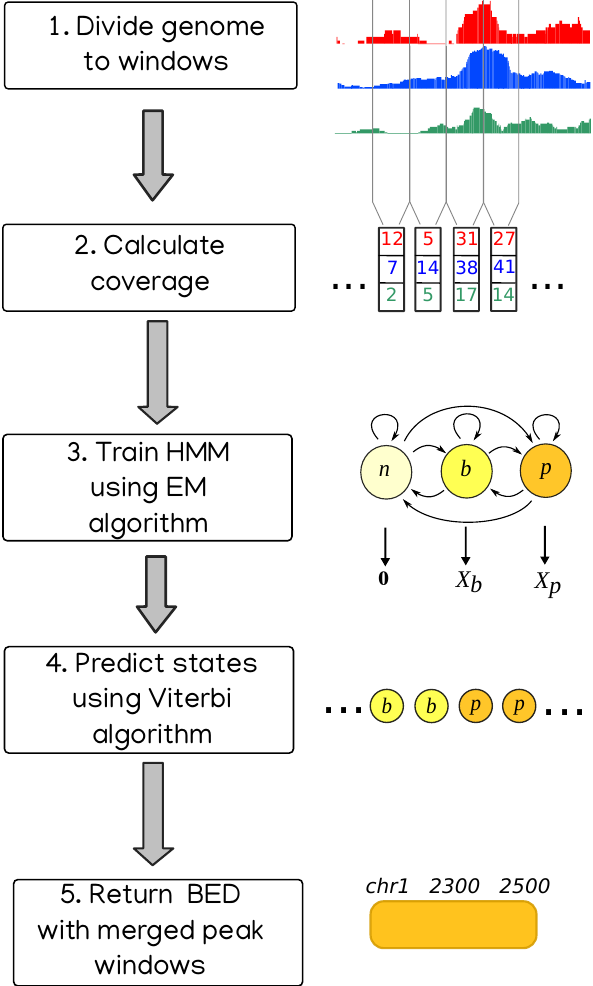
Figure 1. The schematic depicting consecutive stages of the HERON peak calling